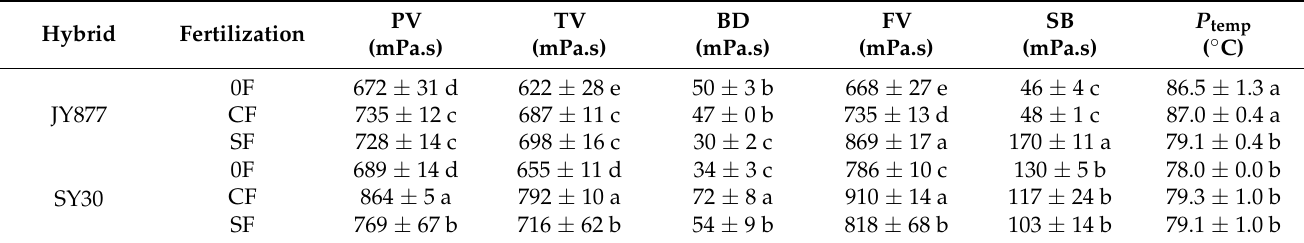
Table 2. Effects of the fertilization mode on starch pasting properties of normal maize.